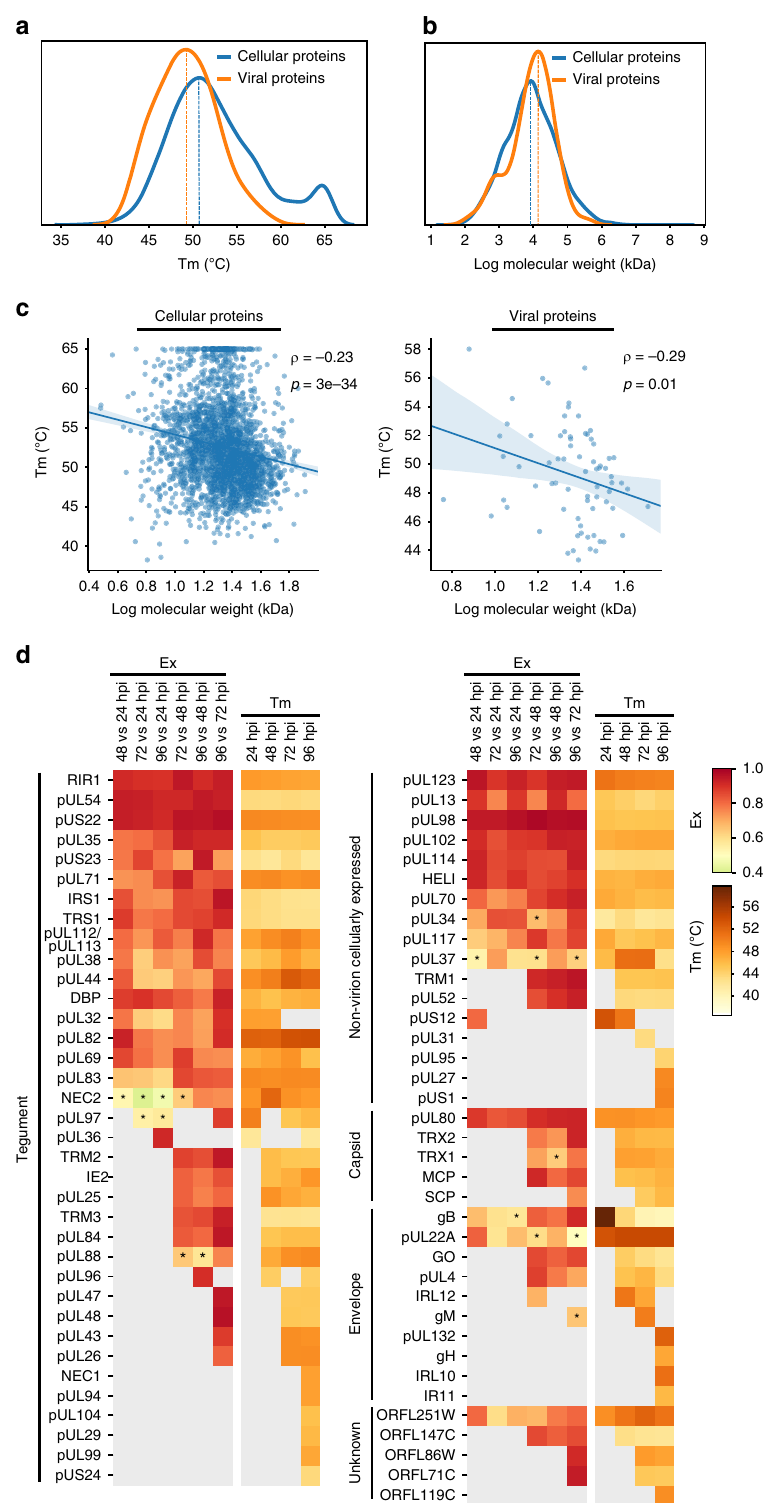
Fig. 7 Viral proteins from different virion compartments display distinct temporal protein properties during infection. a Distribution curves of Tm values for cellular proteins and viral proteins. b Distribution curves of molecular weights for cellular and viral proteins. c Linear correlation between log molecular weight and average Tm of cellular proteins (left) and viral proteins (right). Spearman ’ s ρ and p -values are shown. d Heat map of Ex and Tm values for all quanti fi ed viral proteins clustered by their compartment within the virion. Colors represent Ex or Tm values of the corresponding protein (see scale). Missing values in gray indicate a lack of quanti fi cation or inability to calculate Tm due to lack of a sigmoidal curve. Asterisks indicate p -values < 0.05 based on the distribution of Ex of indicated time